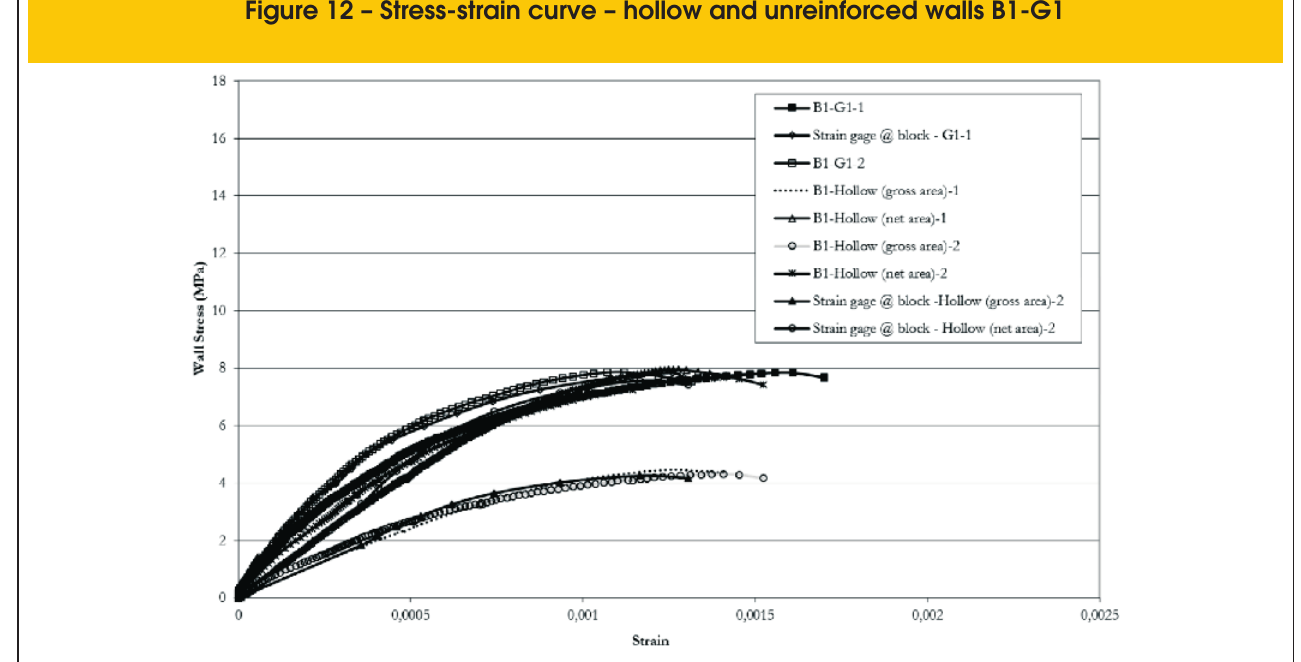
Figure 12 – Stress-strain curve – hollow and unreinforced walls B1-G1